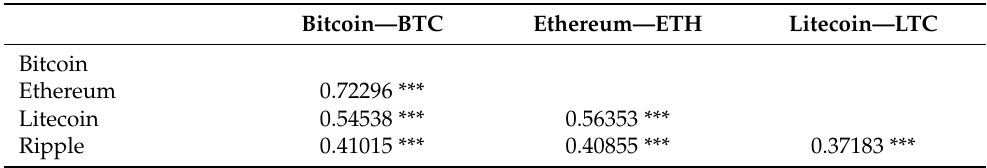
Table 3. Correlation matrix of 1 min